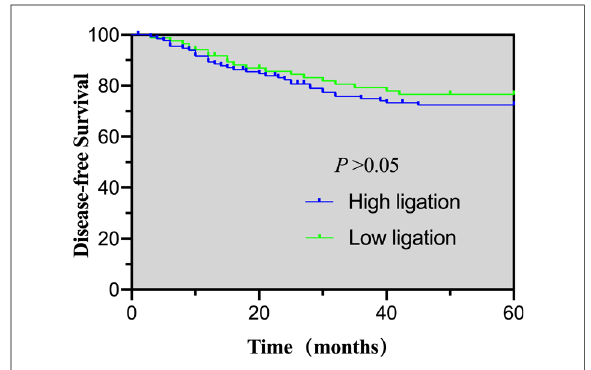
FIGURE 1 5-year disease-free survival of the high- and low-ligation groups.